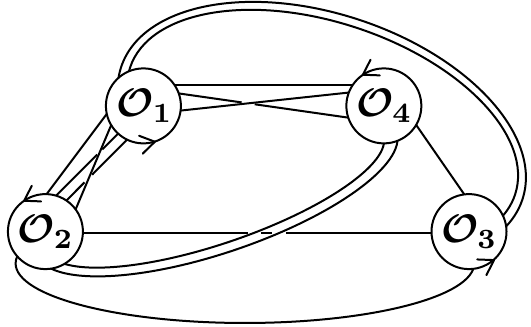
Figure 23 . This diagram corresponds to [ ‘ ] = [1 3 2 2 3 1 4 1 ] ; L = 14 and (cid:22) L = 7. The individual partitions of lengths are ‘ 1 = (4 ; 3 ; 2) ; ‘ 2 = (4 ; 1 ; 2 ; 1) ; ‘ 3 = (2 ; 1 ; 1 ; 1) and ‘ 4 = (3 ; 2 ; 1), given in the counterclockwise